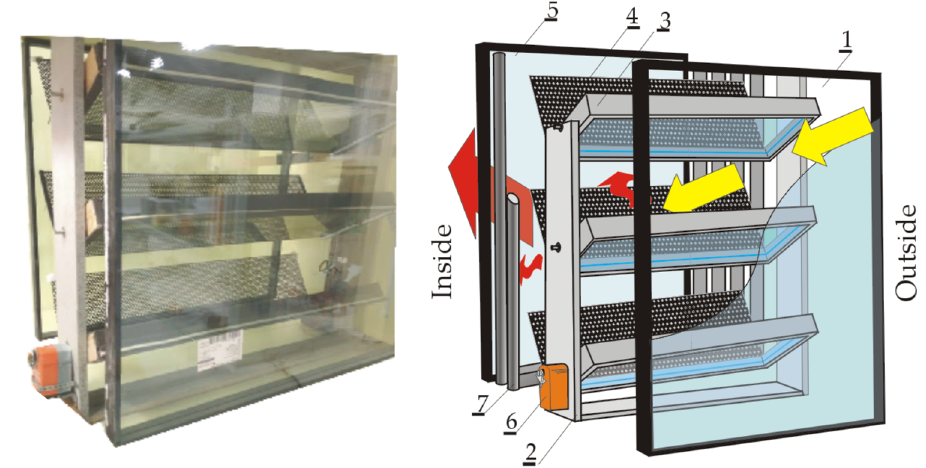
Figure 3. The prototype of the tested interactive glass wall (IGW): 1—outer glazing, 2—louvers headrail, 3—swivelling louvers panels, 4—moveable absorber, 5—interior glazing, 6—louvers panels swivelling actuator, 7—containers with heat storing materials.